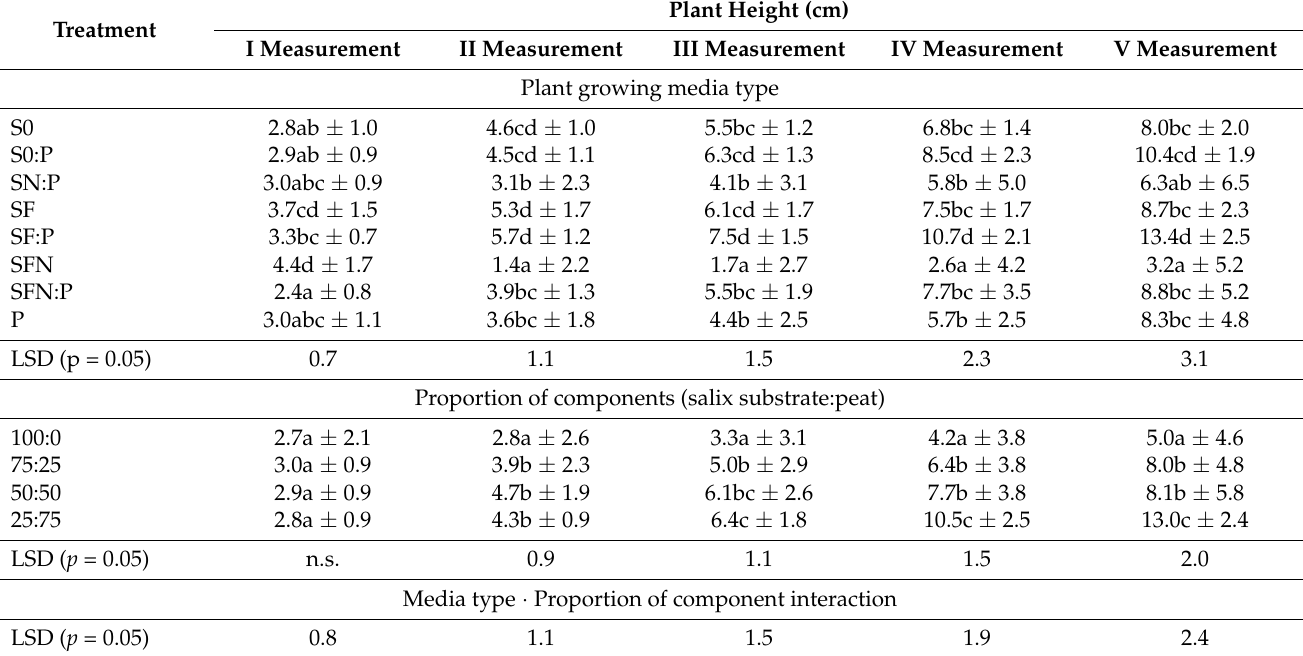
Table 3. The effect of horticulture media on plant growth dynamic (average ± standard deviation).